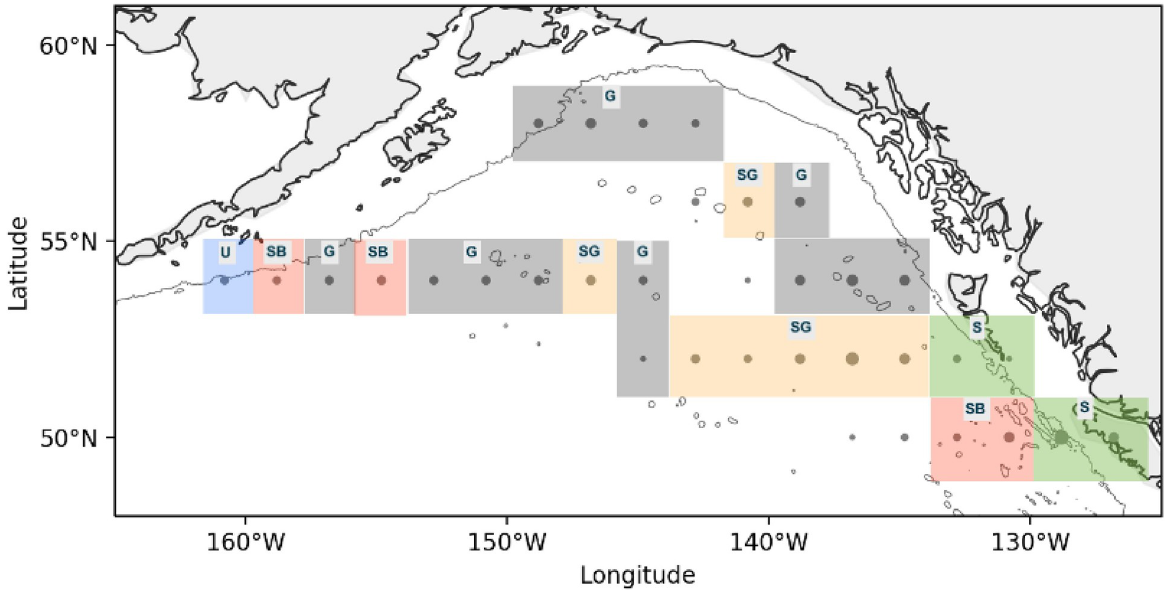
Fig 10. Functional similarities in community response to temperature regimes. Blocks denote regions where the zooplankton community persisted in the central Gyre (G) or shifted (SG = southern central gyre; S = shelf; SB = shelf break; U = Unimak Pass) between warm and cold